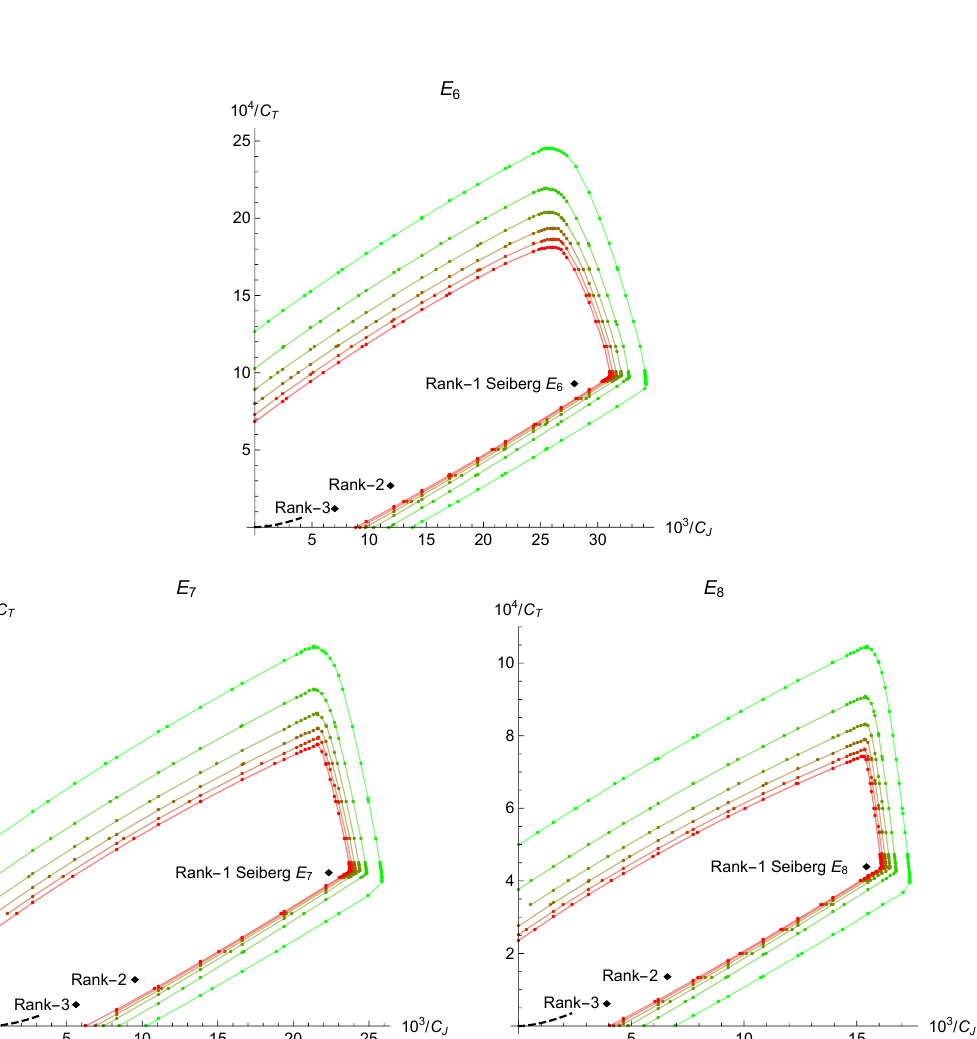
Figure 8. Allowed regions in the C T (cid:0) C J plane for interacting theories with E 1 , E 6 , E 7 , and E 8 (cid:13)avor symmetry, at derivative orders (cid:3) = 20 ; 24 ; : : : ; 40, shown from green to red. Also shown are the four-instanton values in the rank-one Seiberg theories, the perturbative values in the rank-two and three, and the values according to the large-rank formula (dashed line).